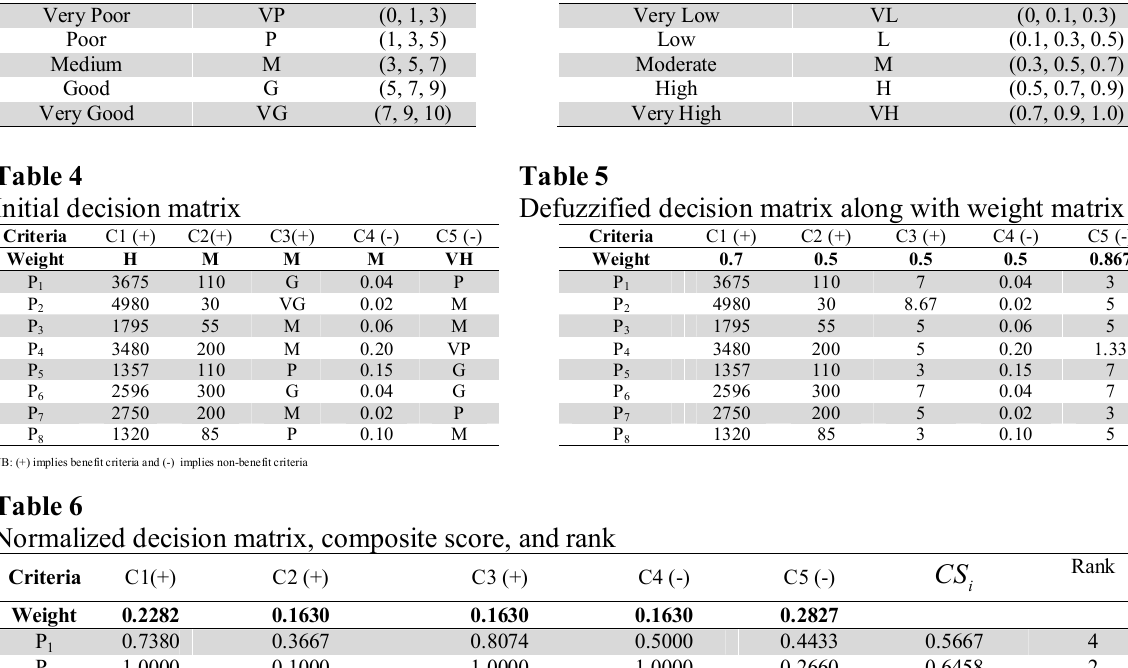
Degree of performance rating Degree of weights of criteria Linguistic Variable